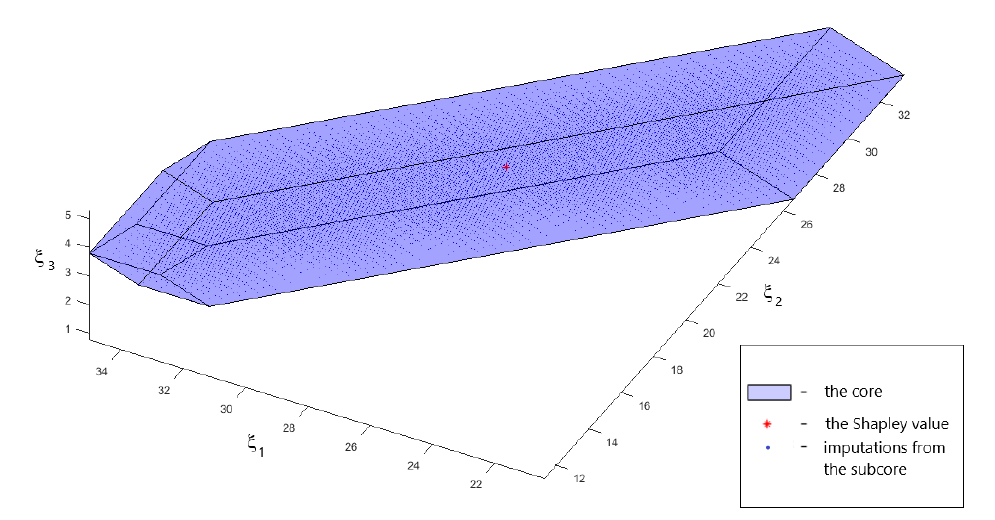
Figure 2. Cooperative solutions in a four-player multi-level marketing